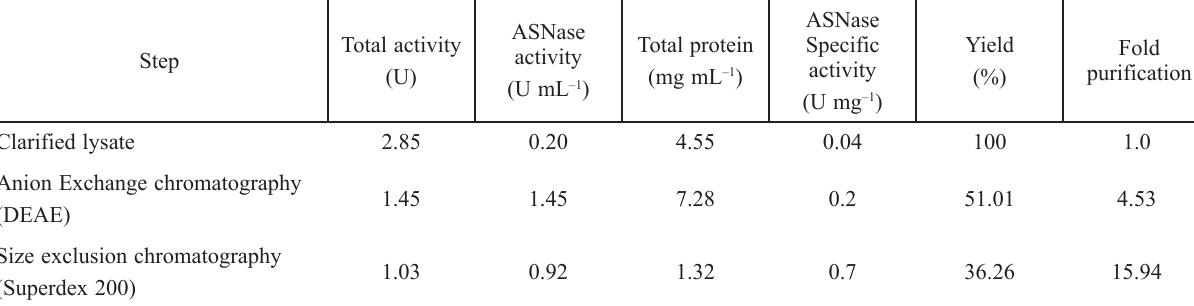
Table 1 – Purification of l -asparaginase from Enterobacter sp. strain M55